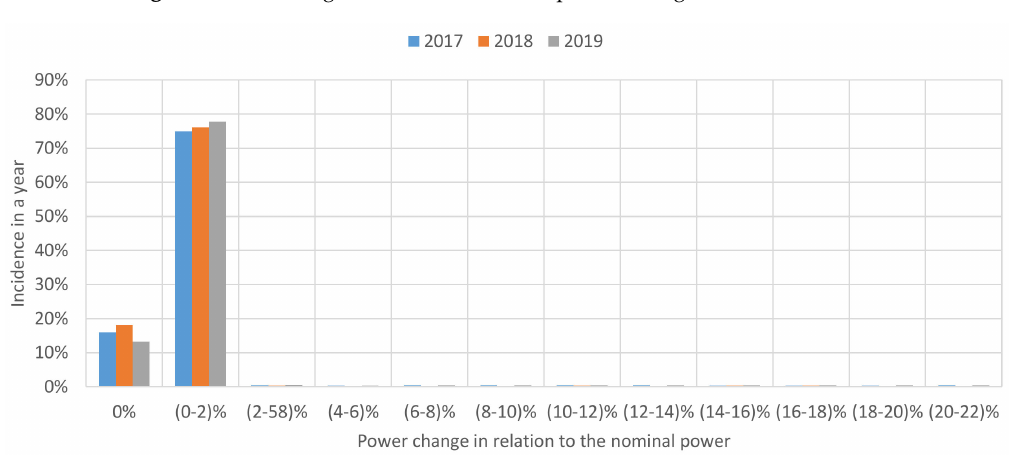
Figure 15. Percentage incidence of relative power change for the hydroelectric power